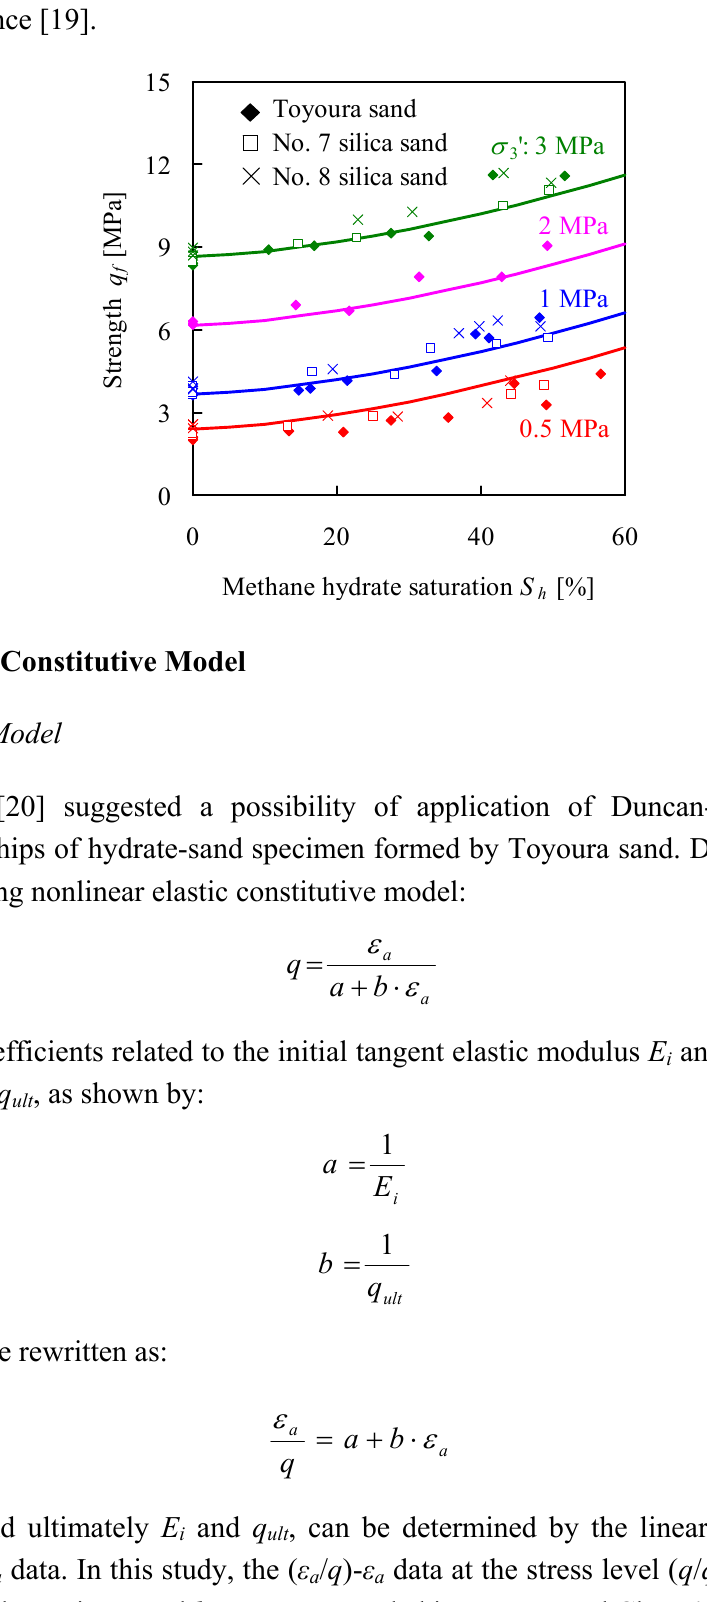
. Experimental results are taken h